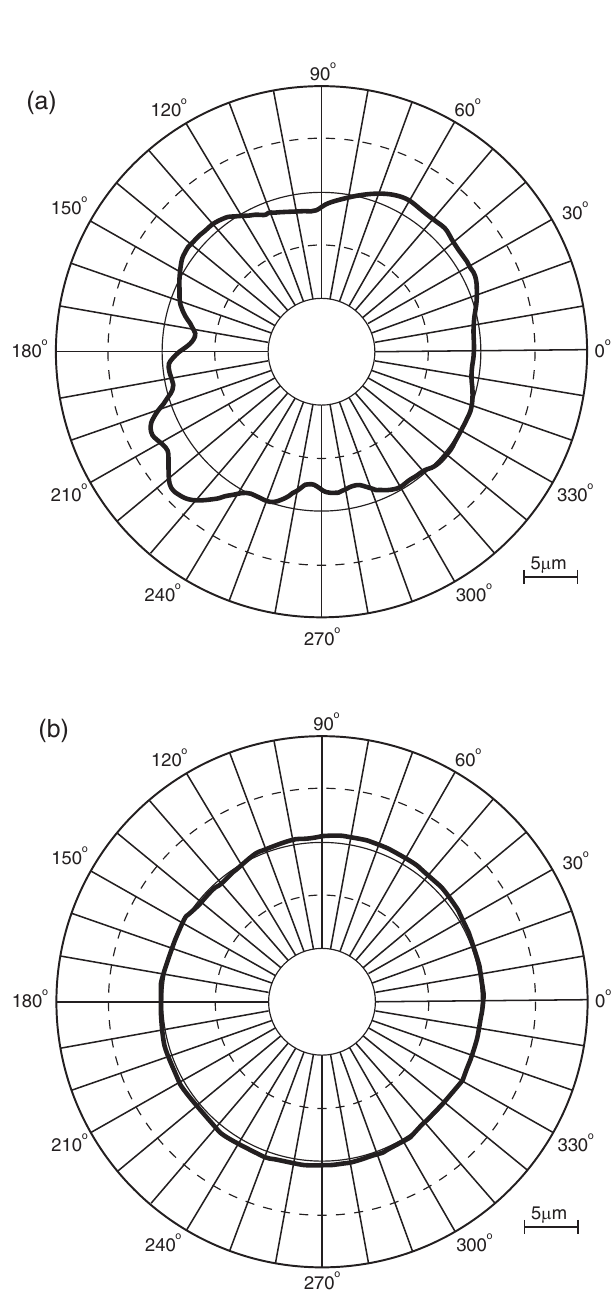
FIG. 12. Measured roundness distribution of the inner bearing rail after the FRTD test for the (a) normal and (b)